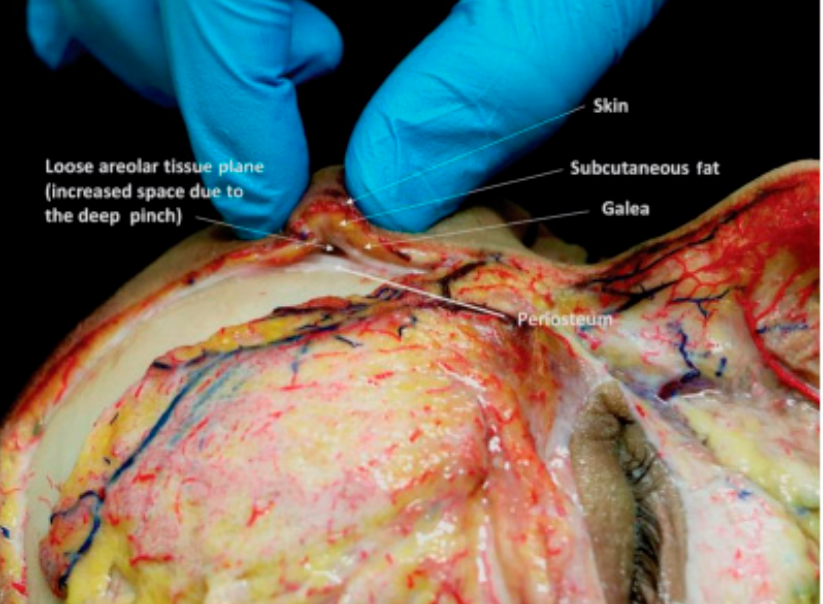
Figure 15. The cadaver dissection demonstrates the “pinch anatomy” of the forehead, with the superficial mobile layers sliding across the periosteum to bunch up, allowing greater room for a needle bevel during filler injection in the loose areolar tissue layer [73].